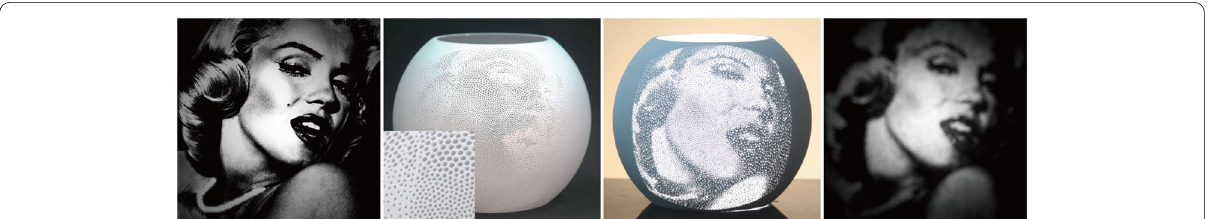
Fig. 6 The radii and orientation of the tubes affect the grayscale of the shadow, Zhao et al. [14] take advantage of this fact to make the lampshade into a shadow artwork